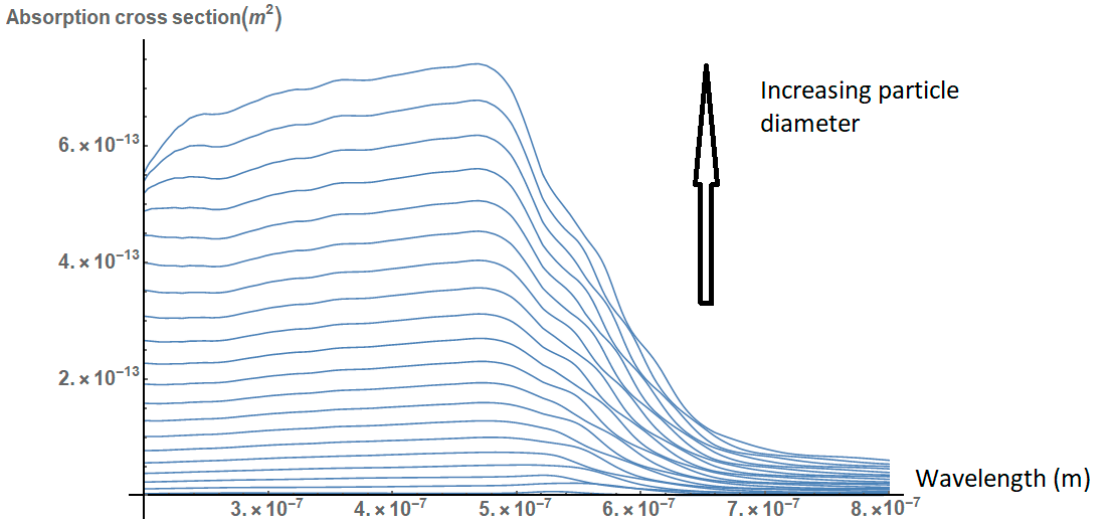
Figure 1. Absorption spectra of gold nanoparticles of different diameters (10–1000 nm). The cross section increases, but the peak lies in the region of 500 nm for all curves.